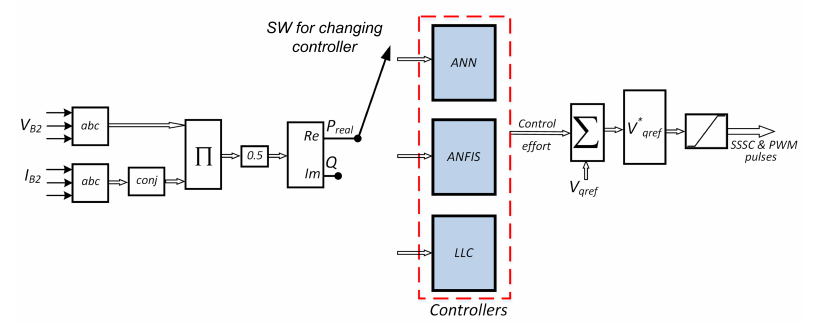
Figure 2. Controller design for the